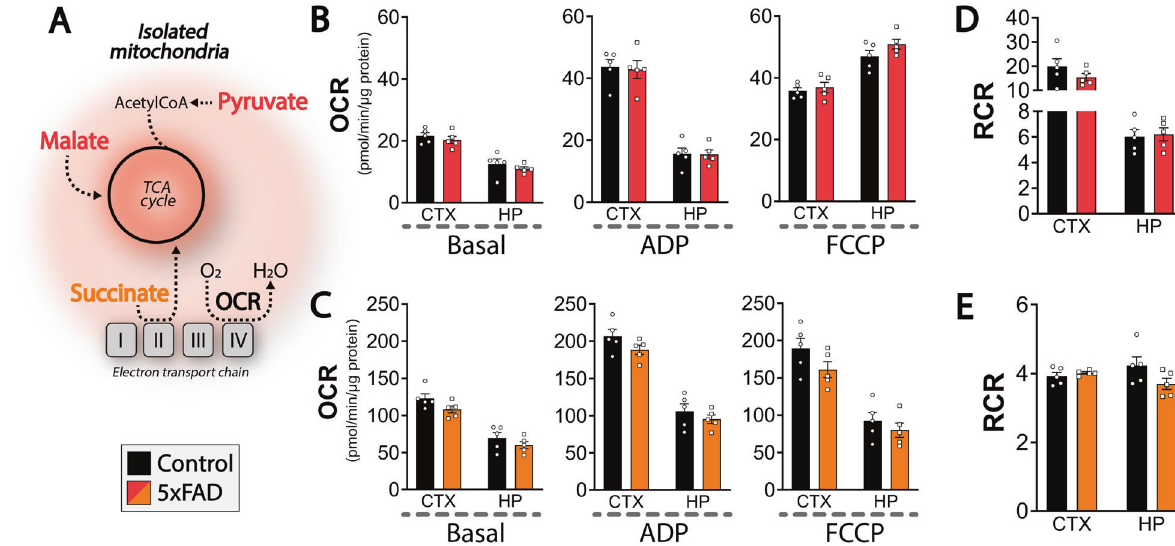
Fig. 5 Non-synaptic mitochondrial function is maintained in the 5xFAD brain. Analysis of oxygen consumption rate (OCR) of isolated non- synaptic cortical and hippocampal mitochondria of 4 months old 5xFAD mice. A The mitochondria were provided with two different substrate combinations: pyruvate in combination with malate ( B , D ) or succinate ( C , E ). The mitochondria were stimulated with ADP, inducing coupled respiration and the mitochondrial uncoupler FCCP leading to maximal uncoupled respiration. Basal refers to non-stimulated OCR. The respiratory control ratio (RCR) is a general measure of mitochondrial function. CTX: cerebral cortex, HP: hippocampus. Mean ± SEM, n = 5, Student ’ s unpaired t -test with Benjamini-Hochberg